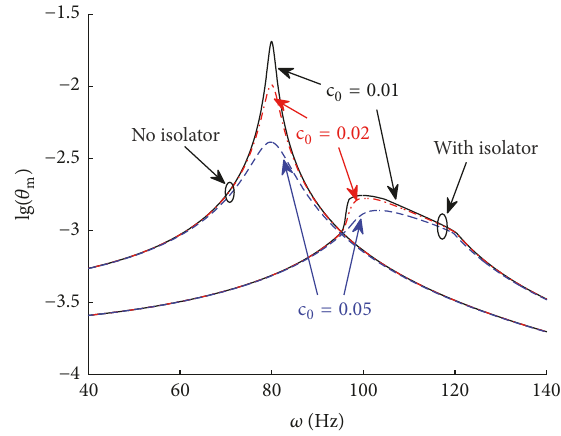
Figure 8: Effect of pole